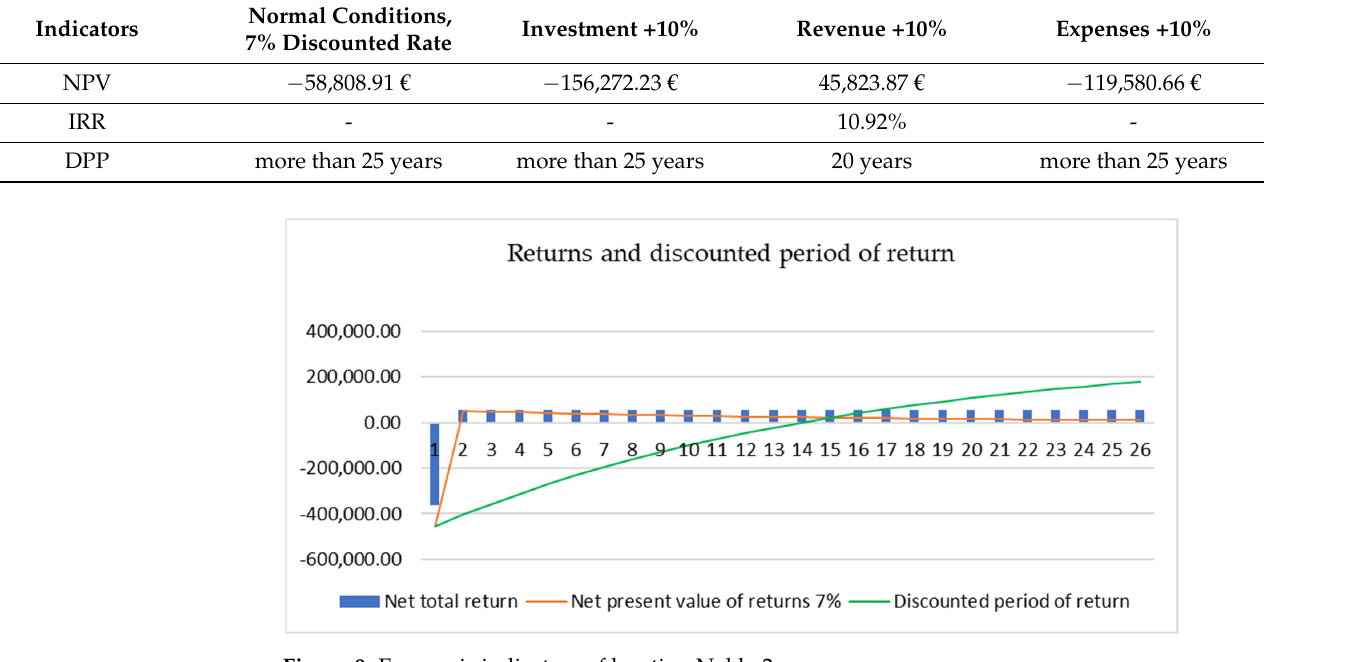
Figure 9. Economic indicators of location Naklo 2. Table 7. Different scenarios of adding corn silage for location Naklo 2.